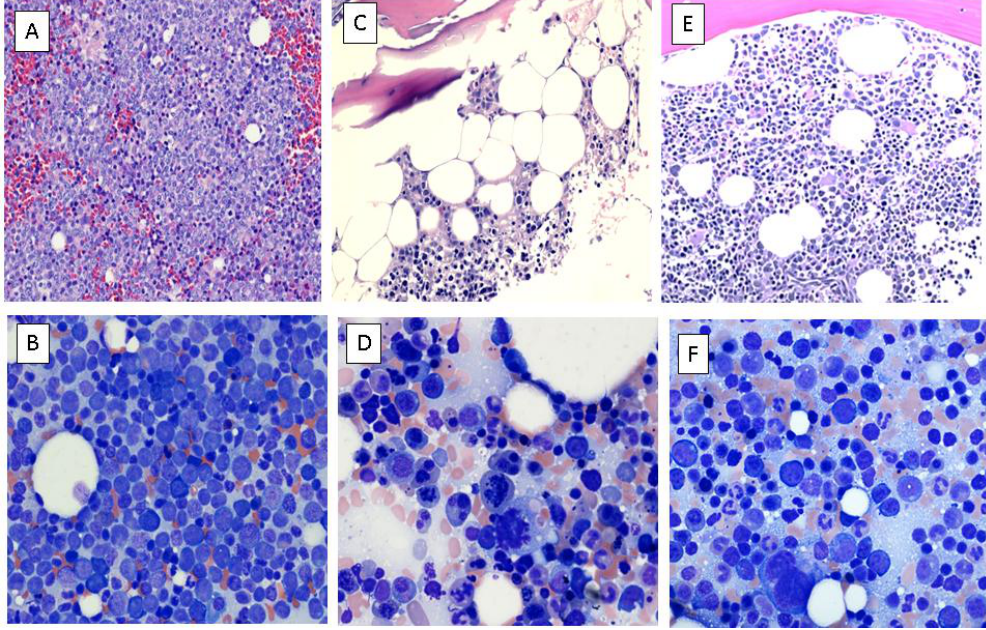
Figure 1 . Bone marrow aspirate, biopsy and clot section smears. ( A ) Clot section at diagnosis (Hematoxylin and Eosin [H&E] stain ˆ 20) showing large hypercellular marrow fragments (cellularity >90%) with predominantly blasts (70%) admixed with maturing erythroid precursors and